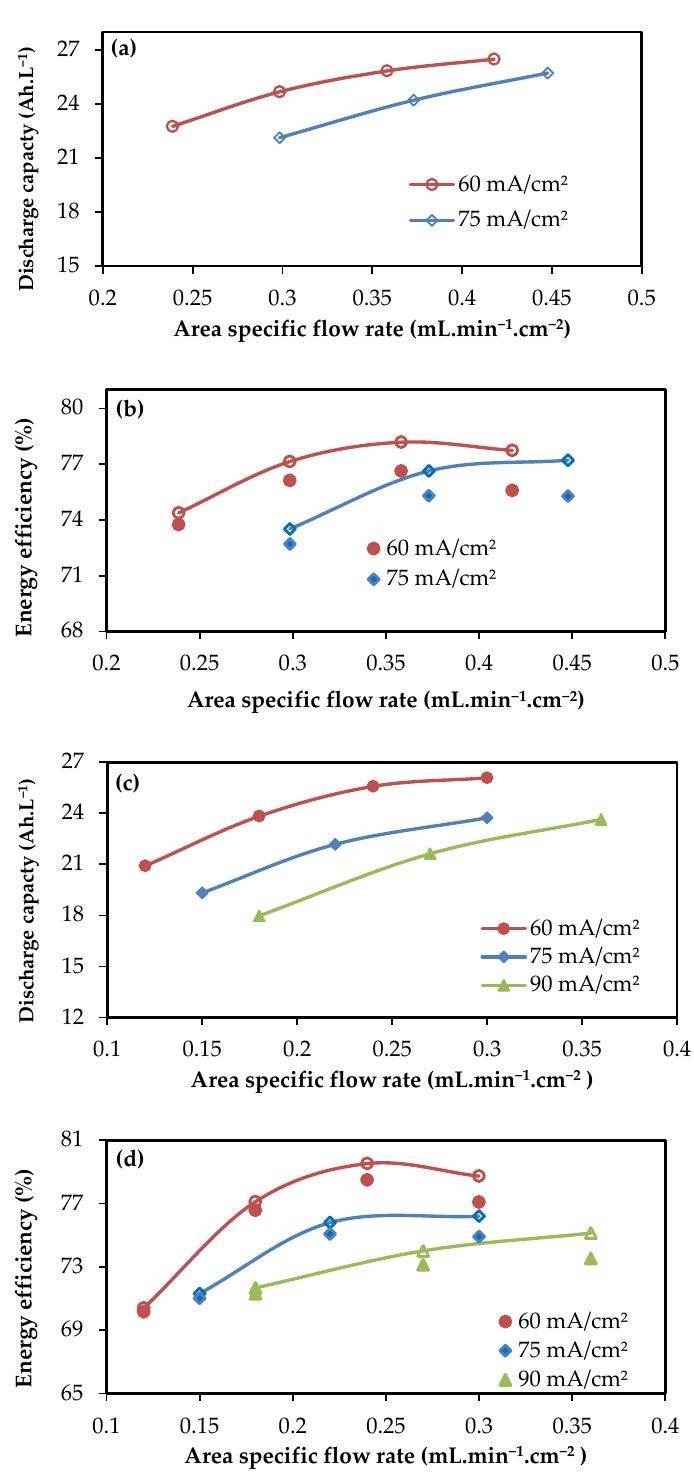
Figure 6. Discharge performance of 8-cell stack of 918 cm 2 cell area ( a , b ) and 8-cell stack of 1500 cm 2 cell area ( c , d ) at various electrolyte flow rates and current densities. The filled symbols in ( b , d ) correspond to energy efficiency, including energy consumption by pumps, and the open symbols correspond to energy efficiency, without considering the pumping power